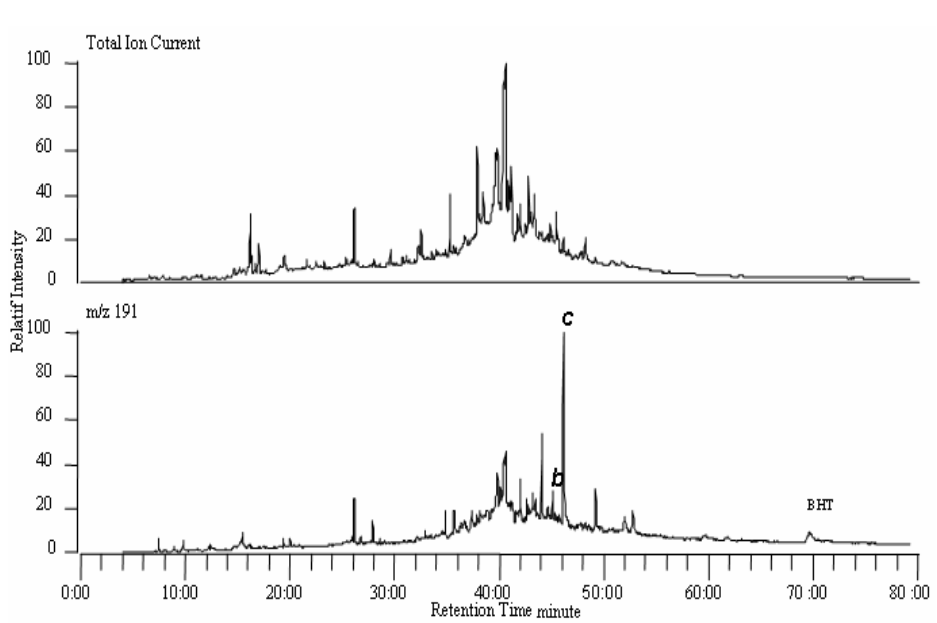
a) GC-MS analysis of acetylated